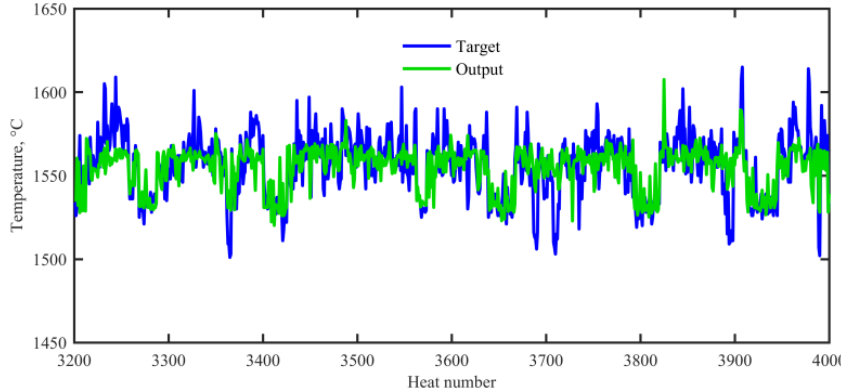
Figure 7. Numerical predictions of the end temperature through the ELM regression model, based on the testing set.